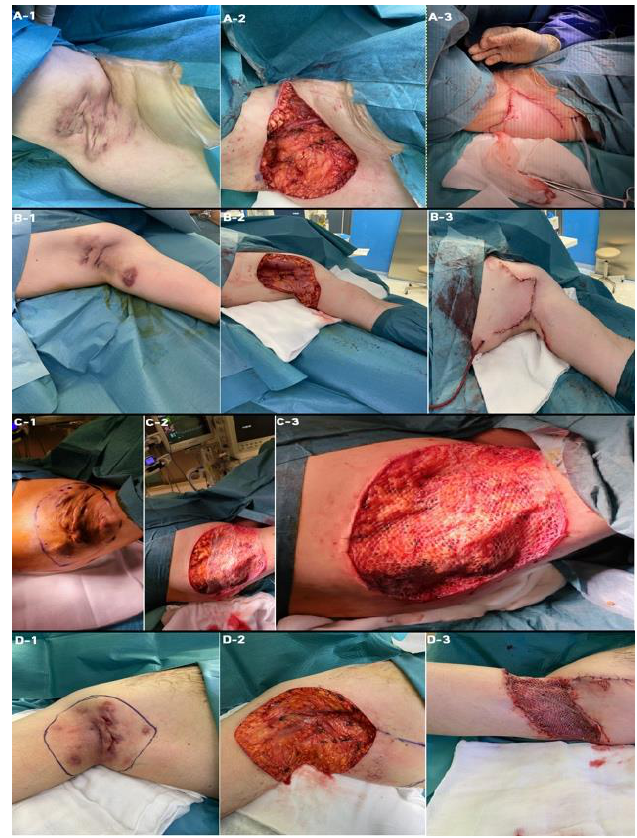
Figure 1. Types of surgical reconstructive techniques used in the surgical treatment of HS. ( A ) Flap reconstruction: left—HS of right axilla ( A-1 ); center—wide excision ( A-2 ); right—rotatory-flap reconstruction ( A-3 ). ( B ) Flap reconstruction: left—HS of left axilla ( B-1 ); center—wide excision ( B-2 ); right—bilobed reconstruction ( B-3 ). ( C ) Split-thickness skin graft: left—HS of left axilla and chest ( C-1 ); center—wide excision and split-thickness skin graft ( C-2 ); right—reconstruction with split-thickness skin graft ( C-3 ). ( D ) Mixed technique (Flap + STSG): left—HS of right axilla ( D-1 ); center—wide excision ( D-2 ); right—reconstruction with a rotatory flap and split-thickness skin graft ( D-3